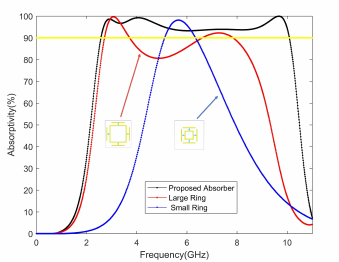
Figure 2. Absorption results of the proposed absorber.